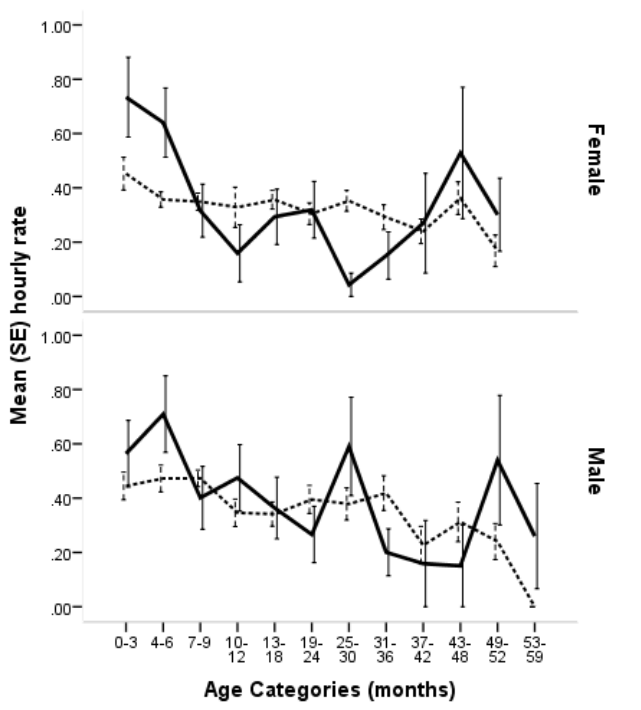
Figure 2 . Hourly rate (log ± SE) of suckling and play for female and male calves from birth to 6 years of age. Time calves spent in independent feeding increased with age, and negatively co-varied with play ( r = -0.241, n = 131, p = 0.006; Figure 3). For older calves, no clear relationship was apparent ( r =